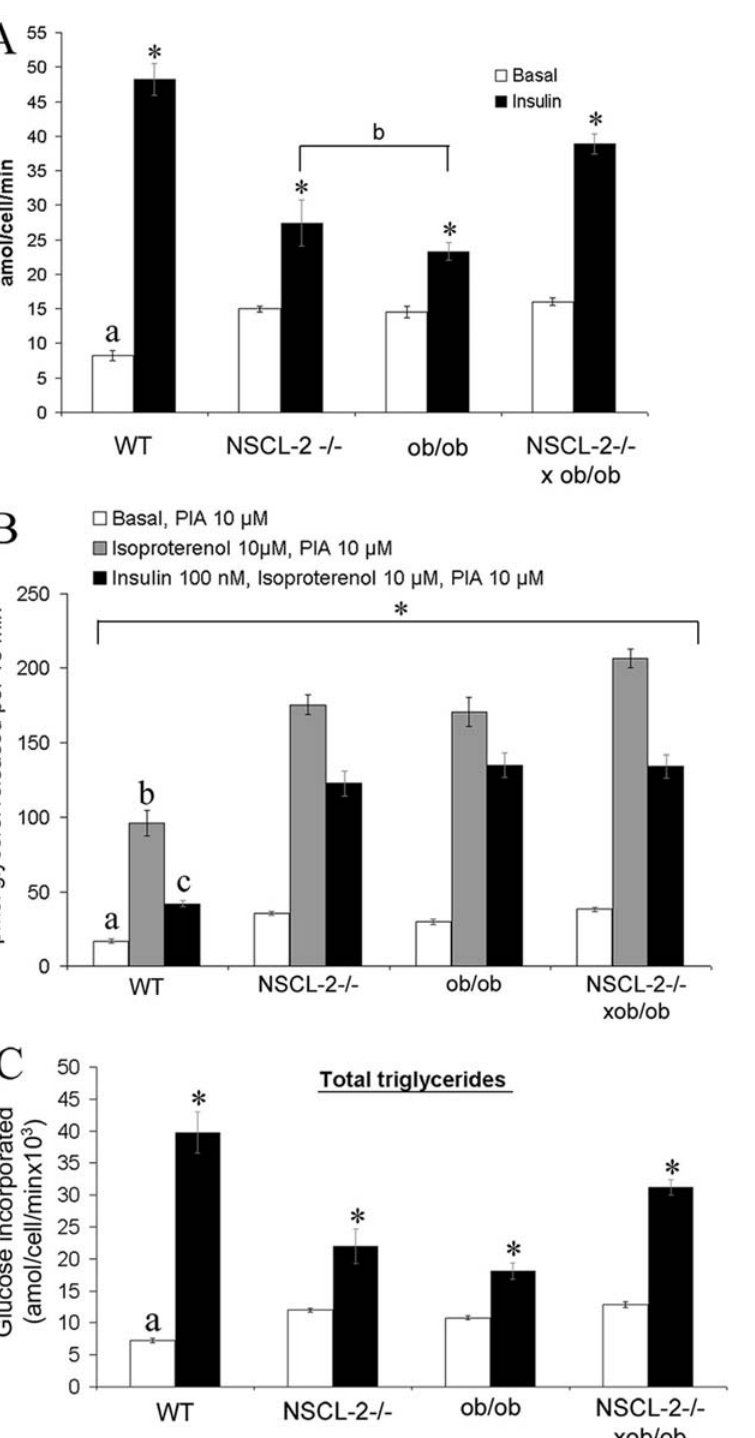
Figure 7. Impaired glucose metabolism and decreased insulin sensitivity in isolated adipocytes of Nscl-2 2 / 2 , Nscl-2 2 / 2 6 ob/ob mice and controls. (A) Basal and insulin stimulated U-[ 14 C]glucose uptake in isolated adipocytes from 6 moth old male WT, ob/ob, Nscl-2 ( 2 / 2 ) mice (n=4) and double mutant mice (n=3). Insulin stimulated glucose uptake was significant higher in all groups compared to basal levels (p , 0.005). a: significant difference between WT basal and basal of all others (F=28.17; dF=3; p , 10 2 4 ), b: significant difference between insulin stimulated glucose uptake by Nscl-2 2 / 2 and ob/ob versus WT and double mutant adipocytes (F=24.22; dF=3; p , 10 2 4 ). (B) Lipolysis in isolated adipocytes. Basal rates of lipolysis in the presence of 10 m M PIA (N6-[R-(-)-1-methyl-2-phenyl]adenosine) were compared to stimulated lipolysis in the presence of 100 m M isoproterenol and to a treatment with 100 nM insulin, 15 min prior to the addition of 100 m M isoproterenol (WT: F=60.8; dF=2; p , 10 2 4 . Nscl-2 ( 2 / 2 ): F=131.8; dF=2; p , 10 2 4 . ob/ob: F=97.1; dF=2; p , 10 2 4 . Nscl-2 ( 2 / 2 ) 6 ob/ob: F=212.1; dF=2; p , 10 2 4 ). a: significant difference of WT basal glycerol release versus basal level of all others (F=44; dF=3; p , 10 2 4 ); b: significant difference of WT maximum glycerol